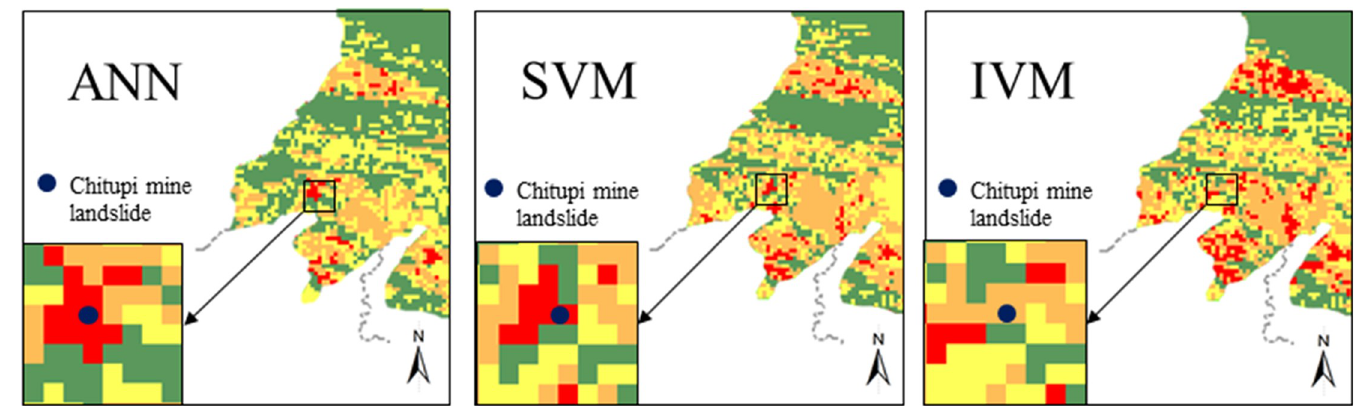
Fig 7. The Chitupi mine landslide estimated result in different